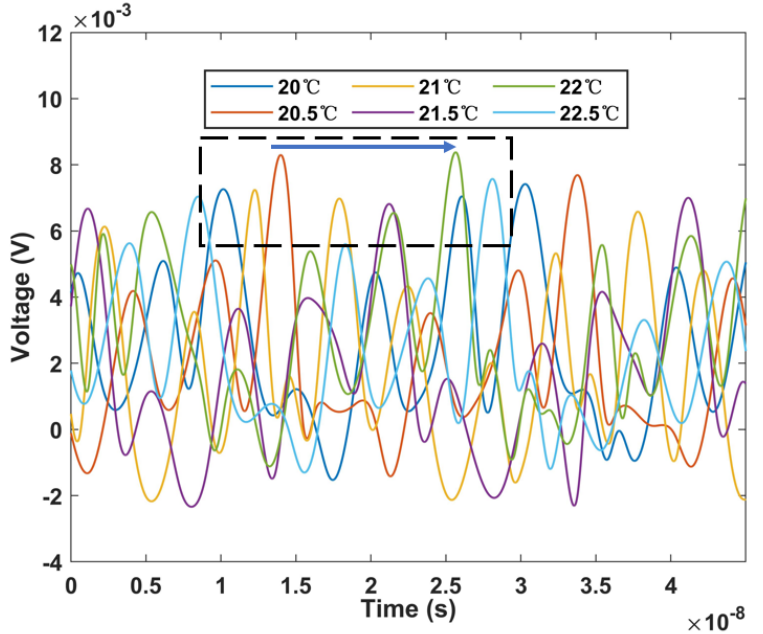
Figure 12. Envelop temporal waveforms characteristics of cascaded Sagnac ring structures with temperature change.